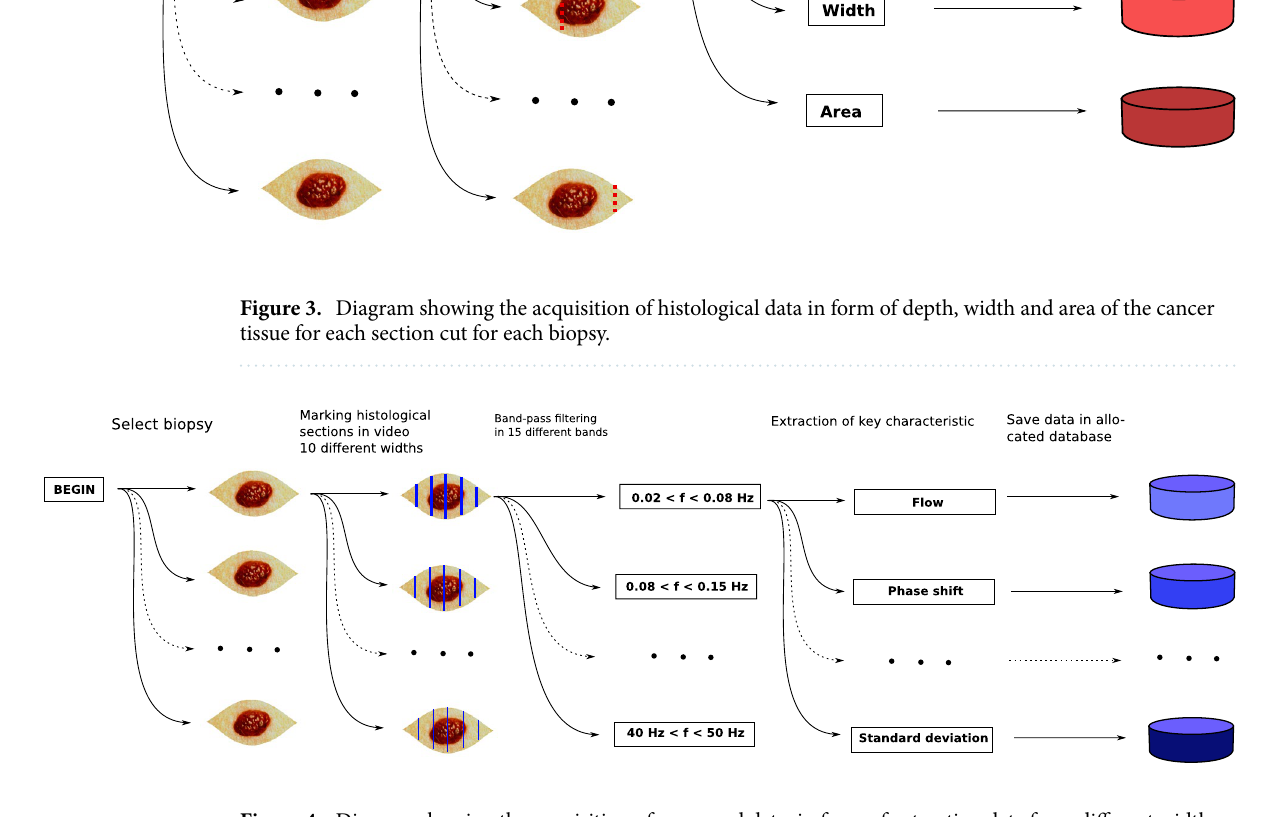
Figure 4. Diagram showing the acquisition of measured data, in form of extracting data from different widths of the digital section masks, band-pass filtering and extraction of the key signal characteristic.